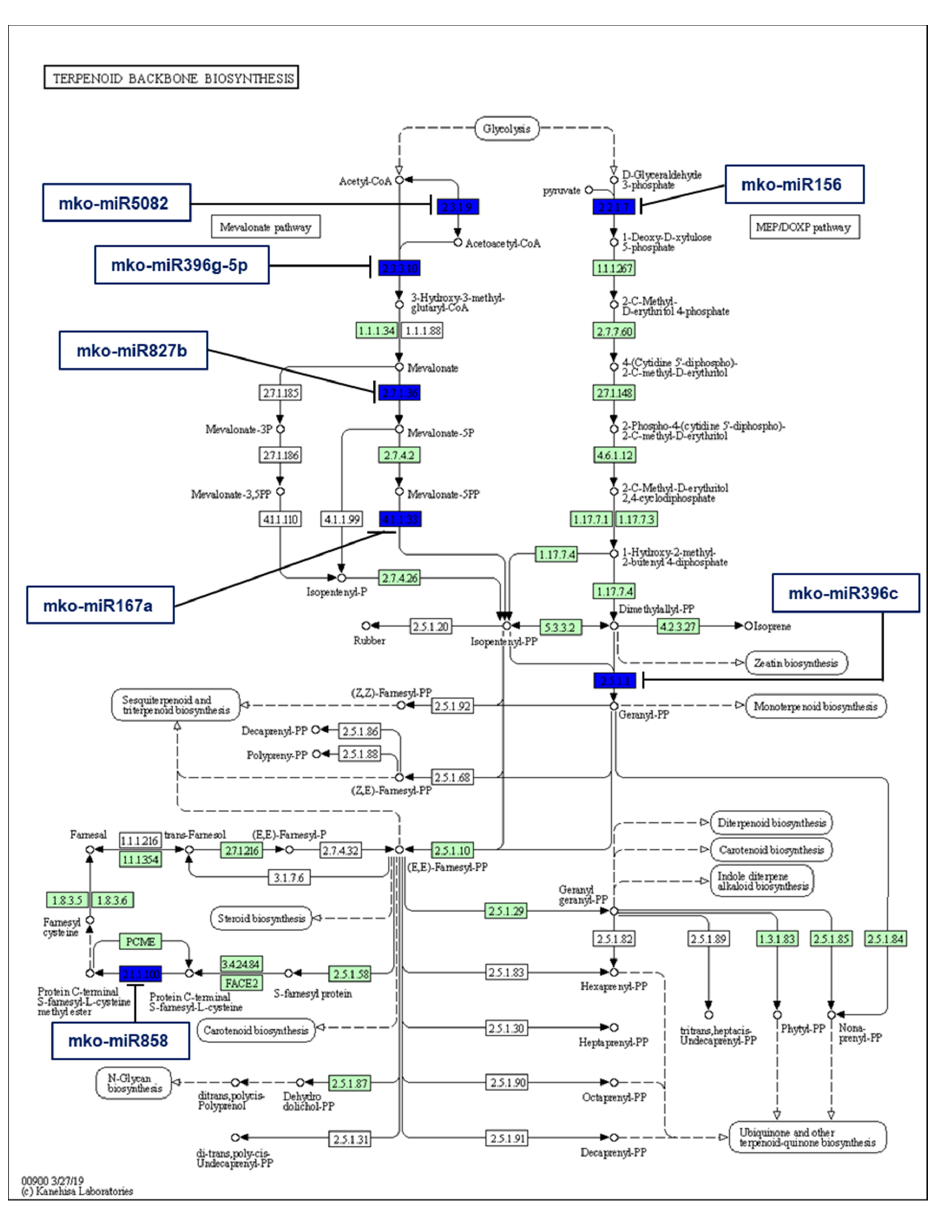
Figure 6. Target enzymes of conserved miRNAs of M. koenigii in the terpenoid backbone biosynthesis pathway. EC:2.2.1.7—1-deoxy-D-xylulose-5-phosphate synthase; EC:2.3.1.9—acetyl-CoA C-acetyltransferase; EC:4.1.1.33—diphos-